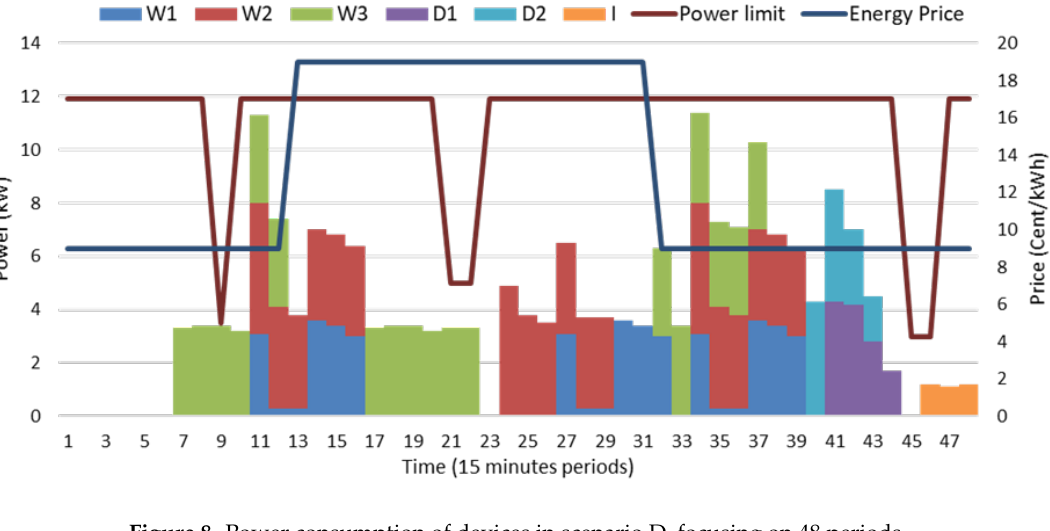
Figure 8. Power consumption of devices in scenario D, focusing on 48 periods.